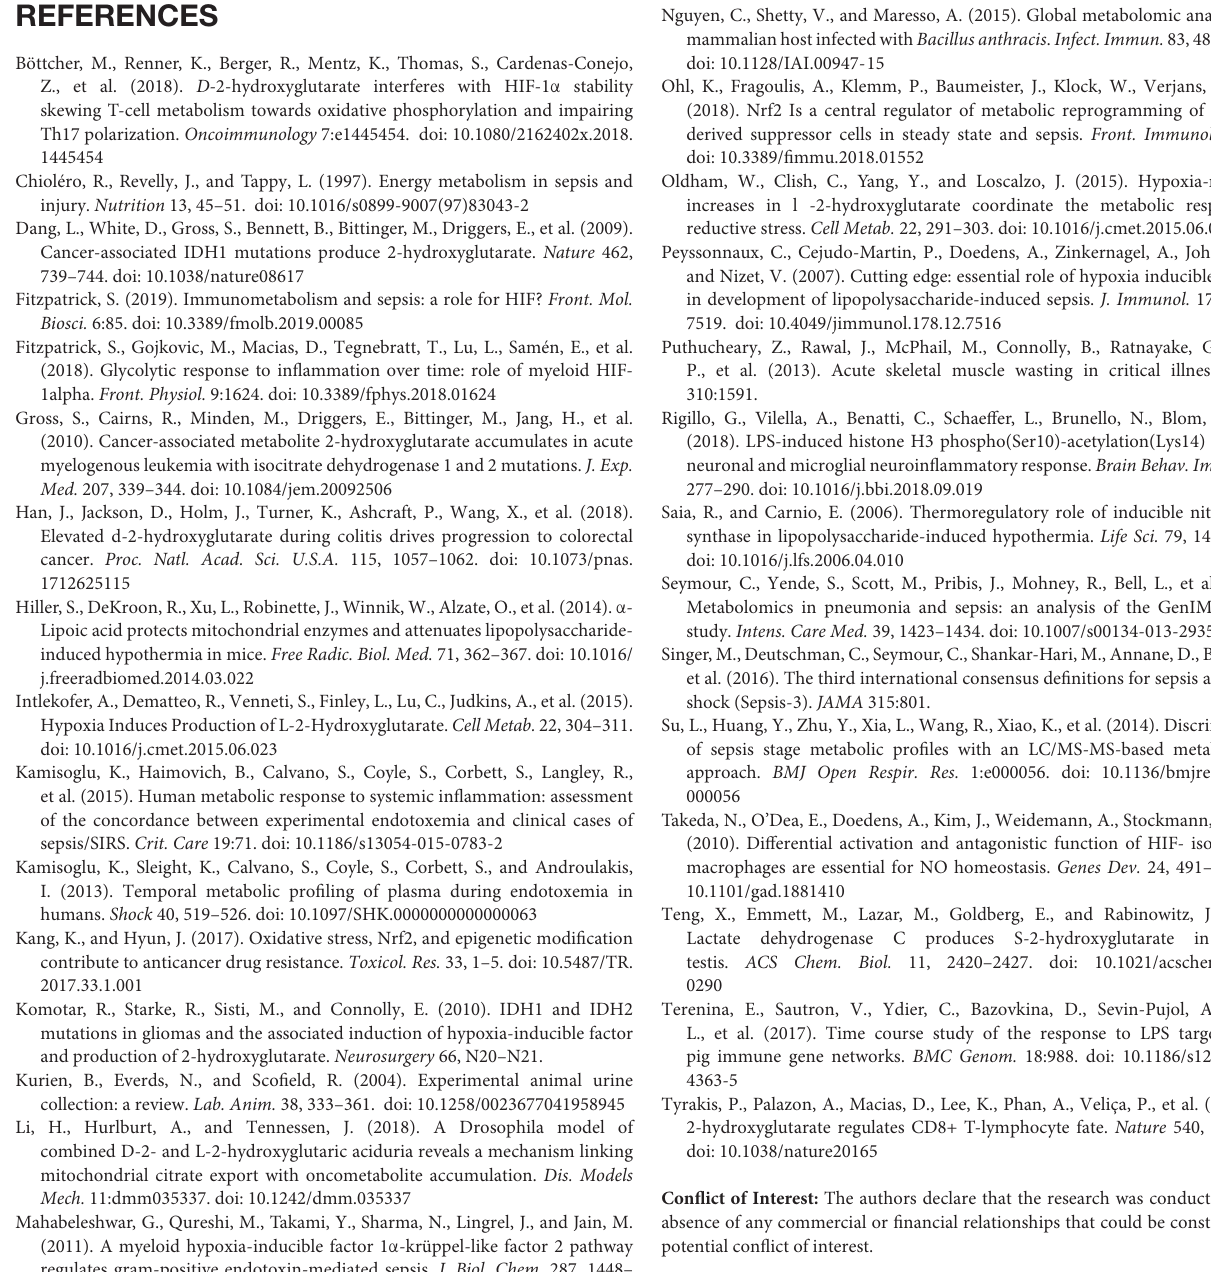
FIGURE S2 | Mice were treated with IFNgamma (20 mg/kg) and urine was obtained over a time course 0–4 h. Urine samples were subsequently measured by mass spectroscopy for both R- and S-2HG. N = 4 or more.